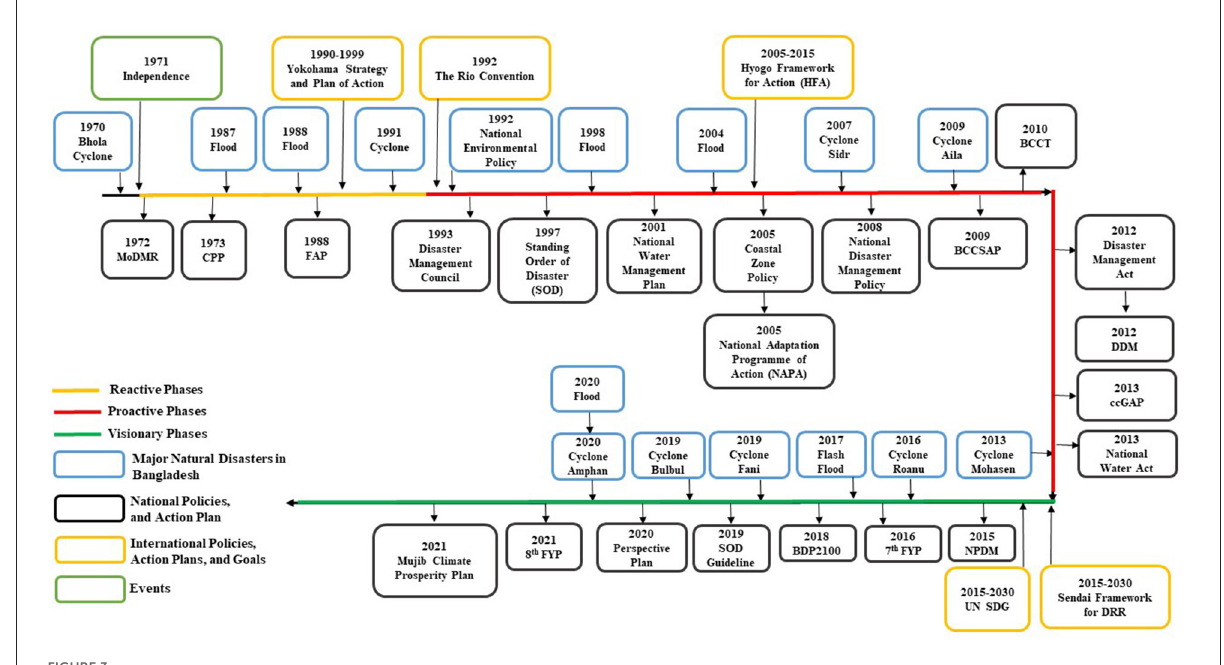
FIGURE3 Journey of Bangladesh towards